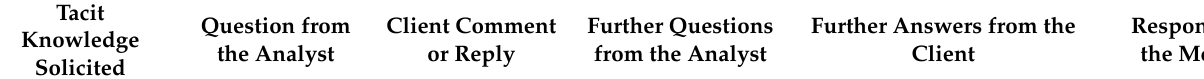
Table 2. Example of tacit knowledge